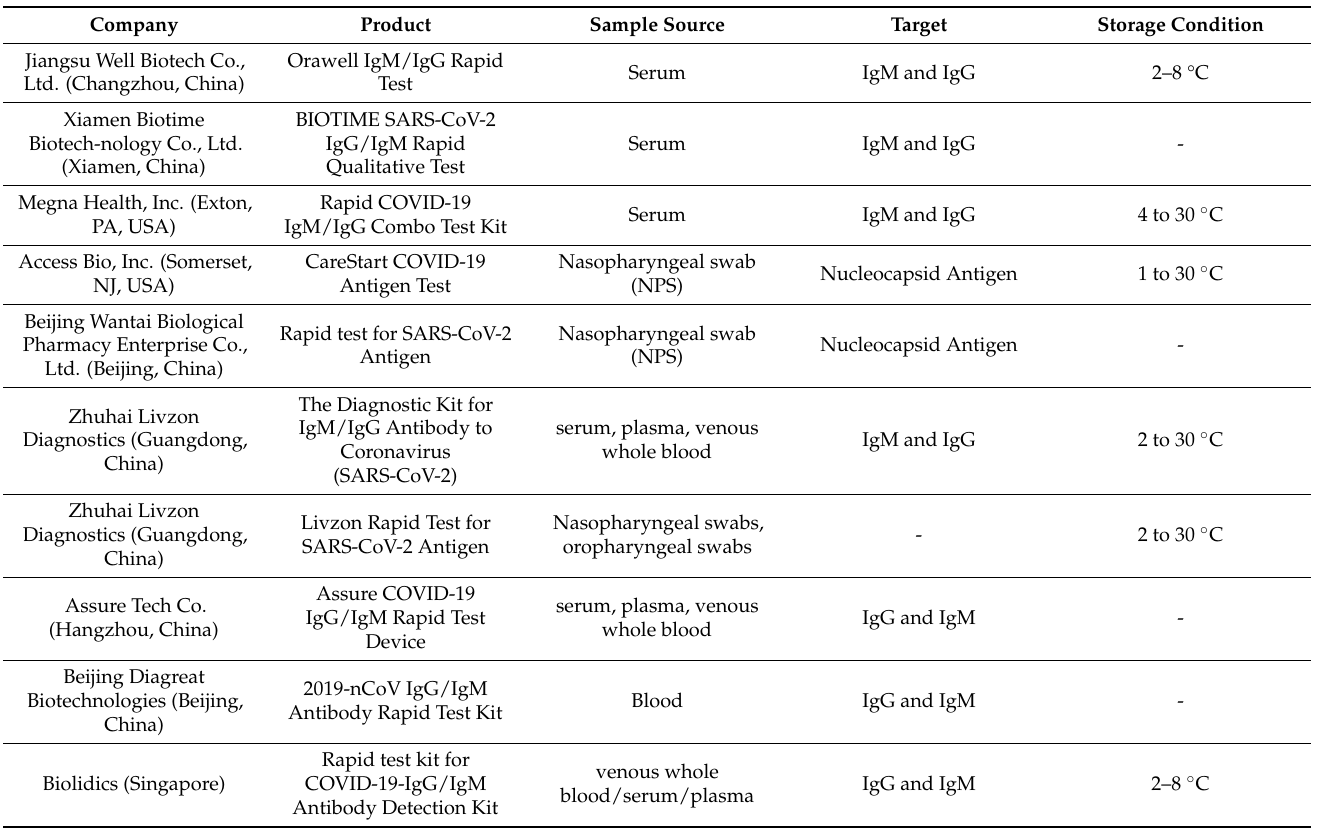
Table 3. Commercialized gold-based lateral flow assay for detection of antigen and antibodies of